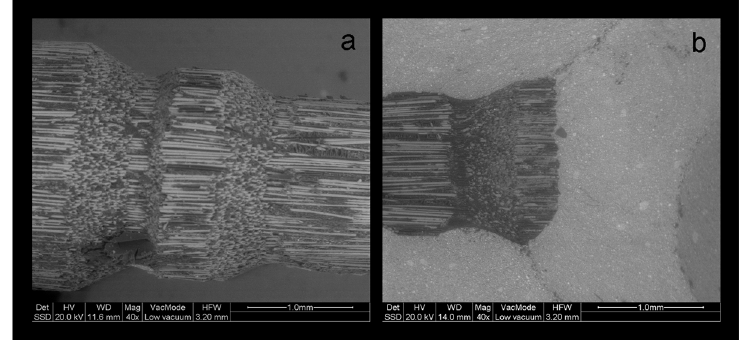
Figure 9. BE LV-SEM image of a debonded ARL post, ( a ) with sheared off retentive elements and ( b ) attached to the core material structure (a: 40×, bar = 1 mm, b: 140×, bar = 300 μ m).